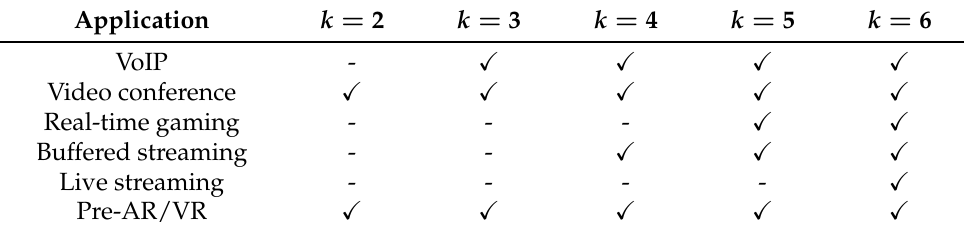
Table 8. Most antagonistic DRBs.